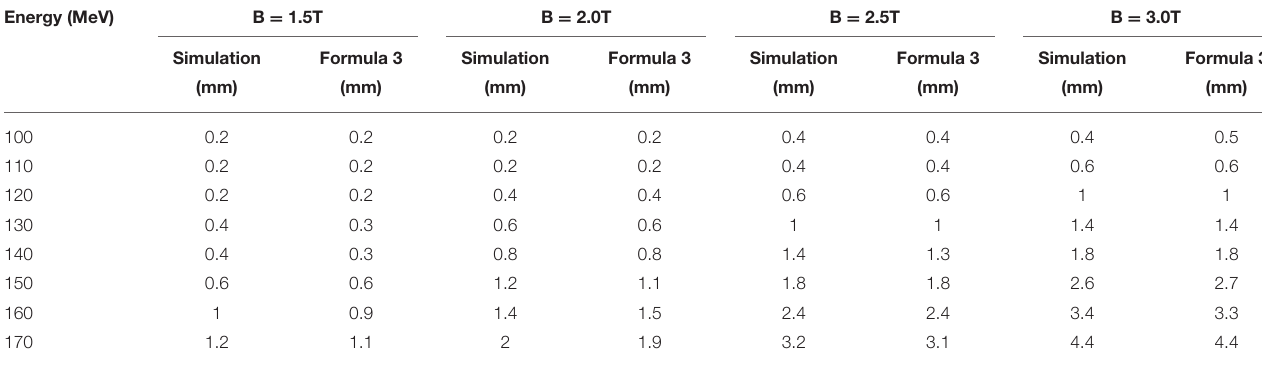
TABLE 2 | Differences of 1 DD between the analytical model of the Equation (3) and the MC simulation. Energy (MeV) B =